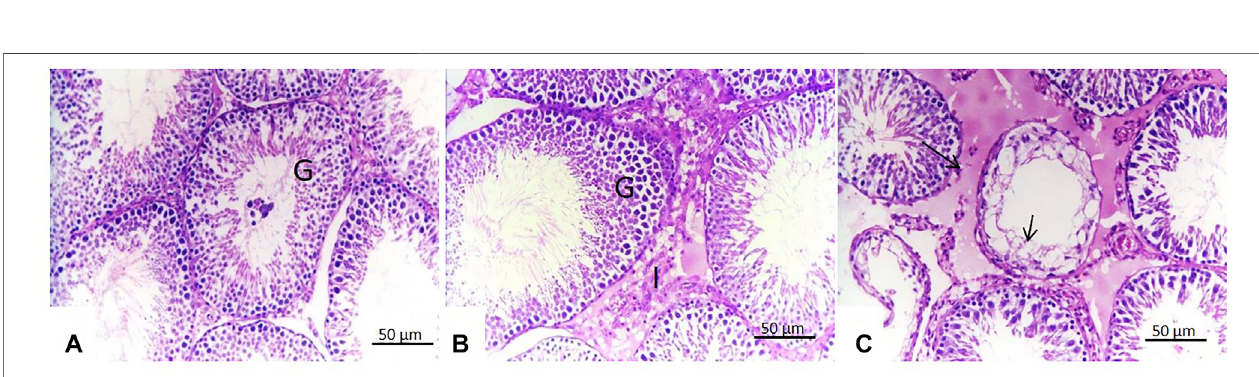
FIGURE7| Effectofmalathiononthetestis. (A,B) Testisofcontrolratsandthosetreatedwithmalathionfor24 hshowingnormaltesticularstructureswithgerminal epithelium (G) in the seminiferous tubules and interstitial (Leydig) cells (L). (C) Testis of rats treated with malathion for 21 days showed testicular degeneration with complete necrosis of the germinal lining epithelium (arrow) of some seminiferous tubules and massive interstitial edema (short arrow).